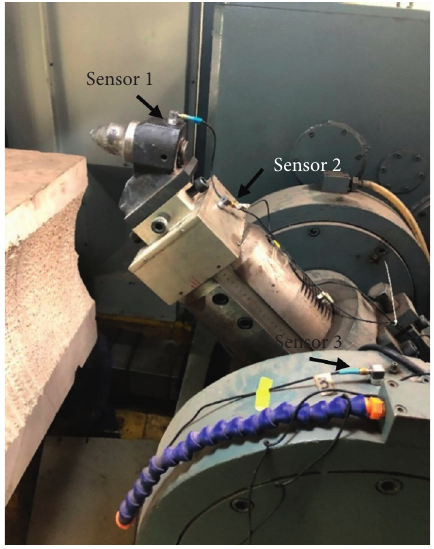
Figure 2: Sensor